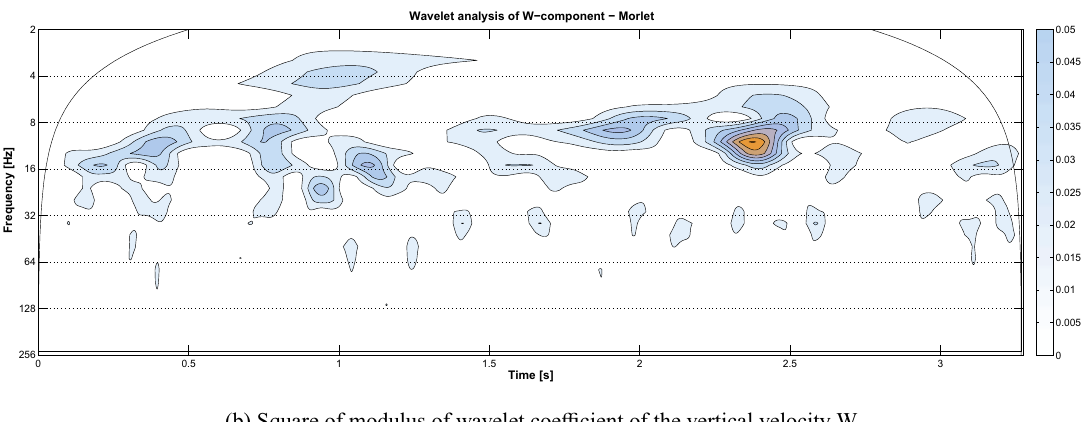
Fig. 4: Wavelet analysis with Morlet as a mother wavelet function applied to velocity time-series from point X / H = 0, Z / H = 1. Two big events are visible at time T = 0.410 s and T =